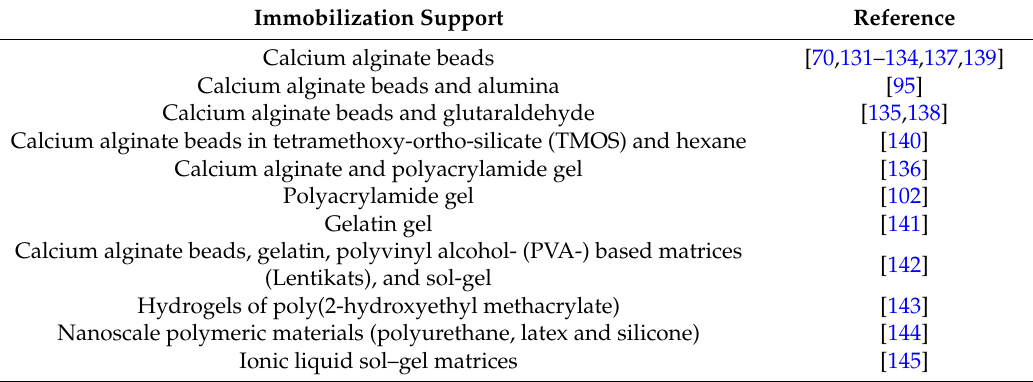
Table 3. β -glucosidases immobilized by entrapment